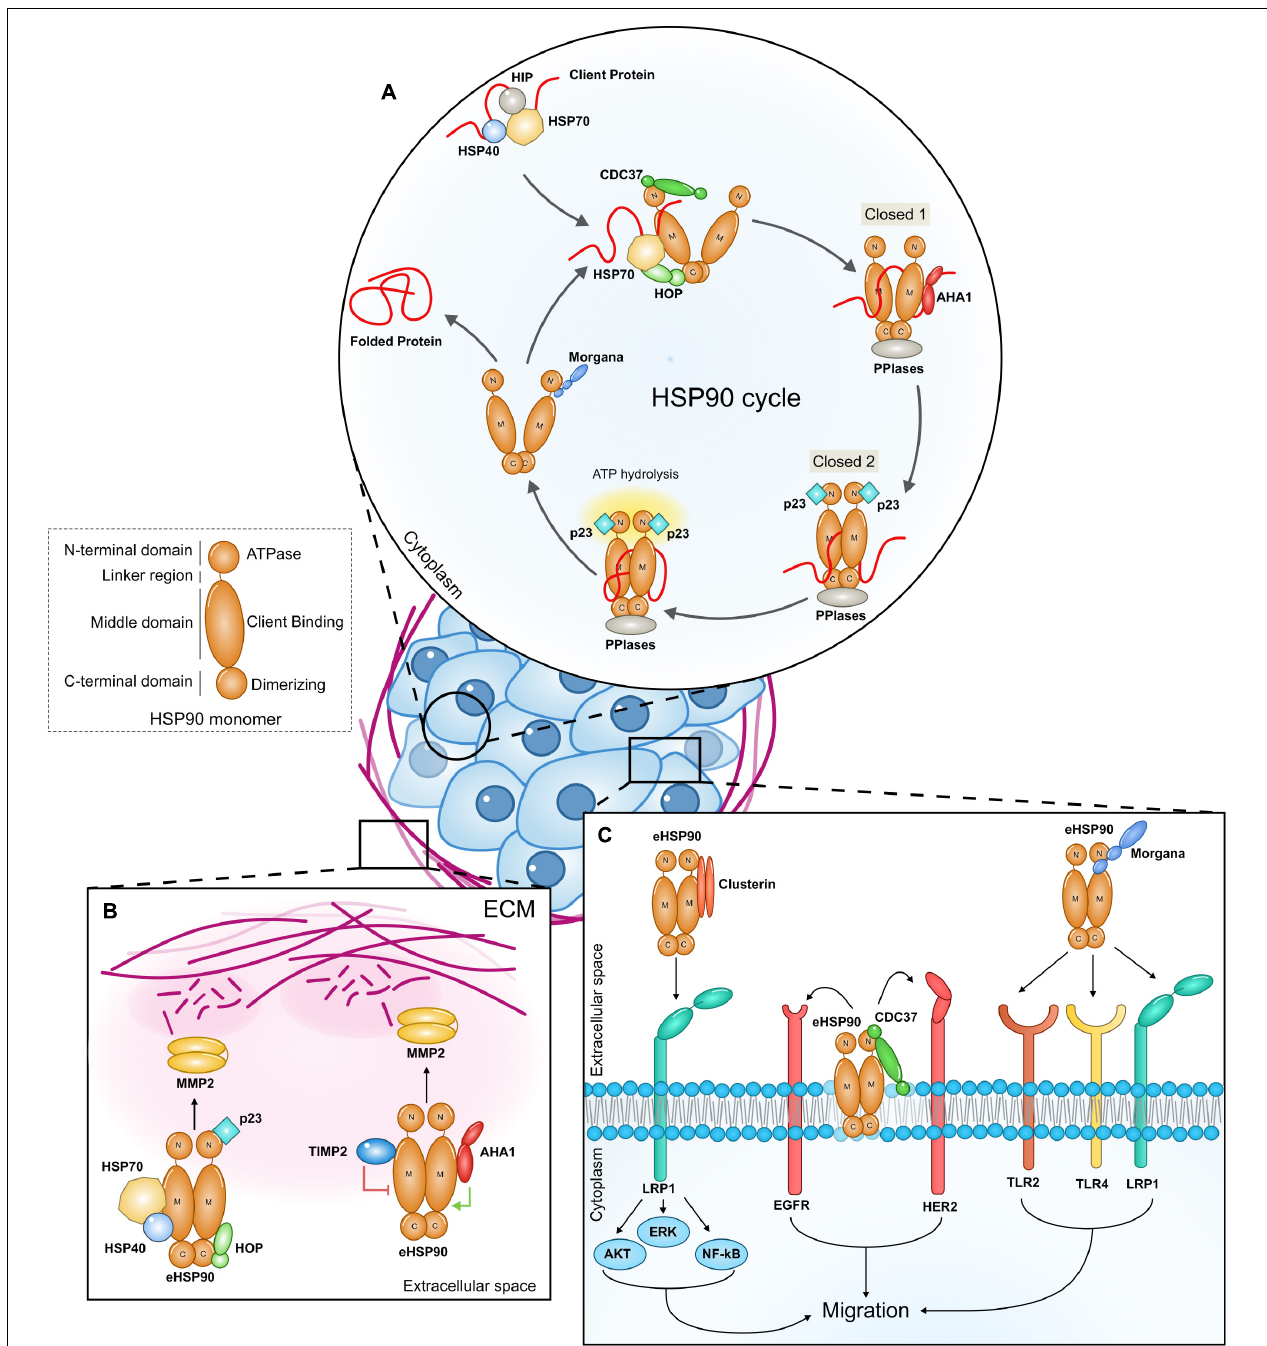
FIGURE 1 | (A) The intracellular HSP90 cycle. The figure highlights the role of co-chaperones that participate to the HSP90 intracellular machinery and that have been also found to be part of extracellular HSP90 complexes. The client protein is initially bound by the HSP70/HSP40 complex and then stabilized by HSP70-interacting protein (HIP). The client protein is loaded onto HSP90 from the HSP70/HSP40 protein complex thanks to the adaptor protein HOP (HSP90–HSP70 organizing protein). The co-chaperone CDC37 (cell-division-cycle 37 homolog) is required by HSP90 to bind client kinases. As the client protein is loaded, other co-chaperones, peptidyl-prolyl-isomerase and PPIases (FKBP51, FKBP52) join the complex while the HSP70, HIP, and HOP are released. AHA1 (activator of HSP90 ATPase homolog 1) binding induces HSP90 to switch from the open state to the closed 1 state, while p23 induces ATP hydrolysis and the transition toward the closed 2 conformation. The co-chaperone Morgana interacts with HSP90 in the ADP-bound state. (B,C) Extracellular HSP90 (eHSP90) complexes promote cancer cell migration. eHSP90 released by cancer cells binds to different secreted co-chaperones in the extracellular milieu. eHSP90 complexes interact with extracellular client proteins favoring ECM remodeling (B) and with surface receptors (C) , triggering intracellular signal transduction (ECM, extracellular matrix; M, HSP90 Middle domain; C, HSP90 C terminal domain; N, HSP90 N terminal domain).